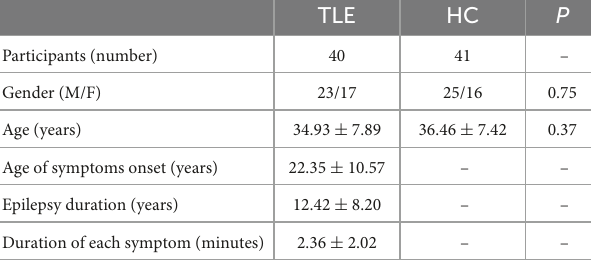
TABLE 2 Demographic and clinical characteristics of all